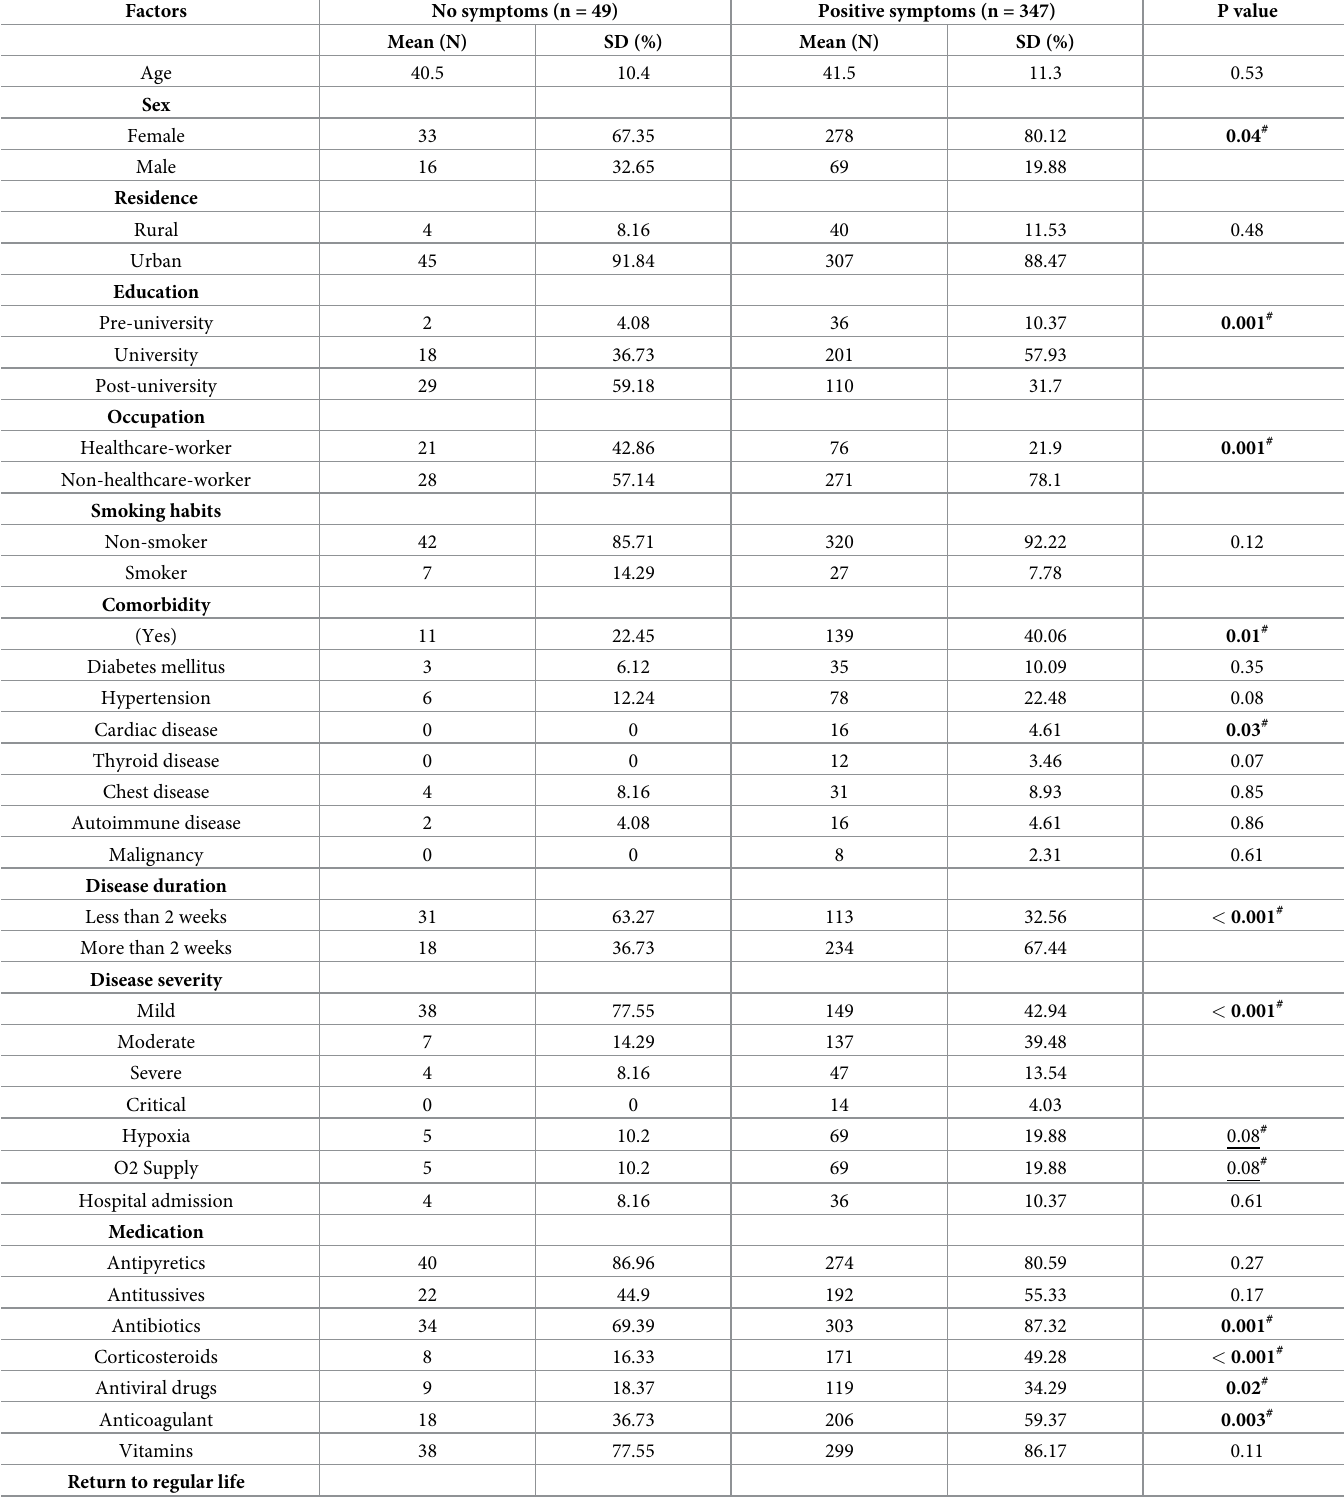
Table 2. Factors associated with the development of post-COVID